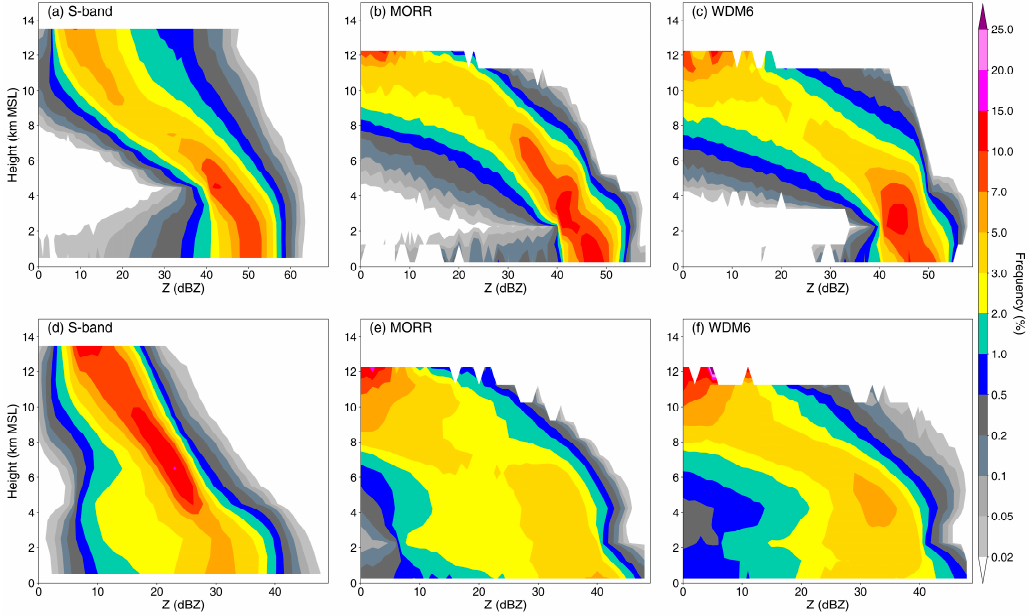
Figure 10. Contoured frequency by altitude diagrams (CFADs) for reflectivity over (top panels) convective and (bottom panels) stratiform regions, from ( a , d ) S-POL radar and the ( b , e ) MORR and ( c , f ) WDM6 microphysics schemes. The time period of the analysis is 1200–1500 UTC.